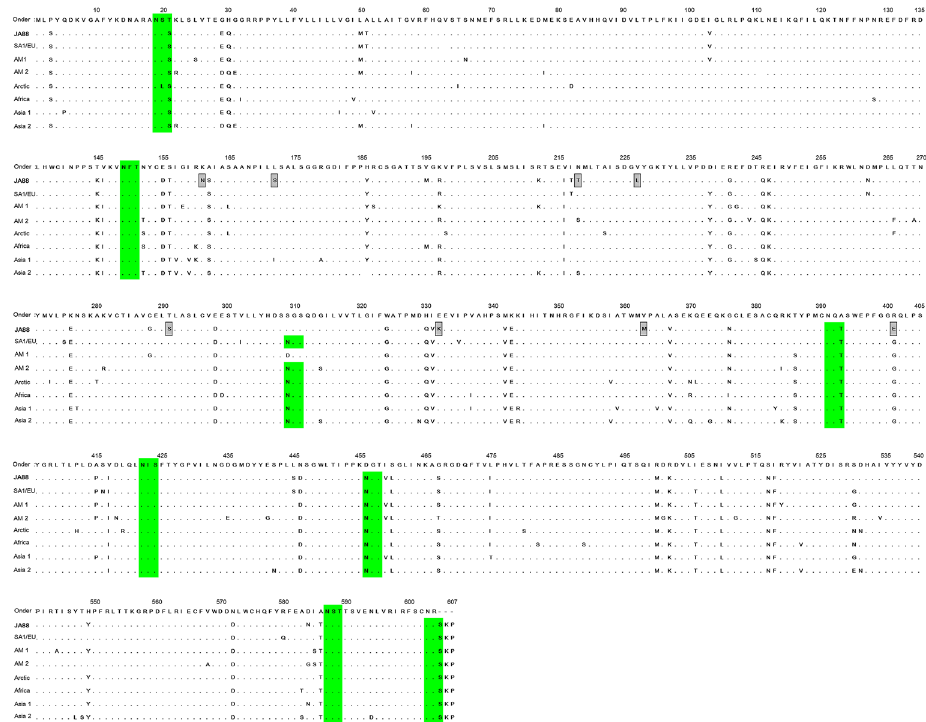
Figure 5. Amino acid sequence alignment of the CDV H protein from the Onderstepoort vaccine strain (AF305419); a wild-type strain from Brazil (JA88); and seven wild-type strains from Uruguay (SA1/EU: KM280689), the United State of America (AM1: EU716337; AM2: AY542312), Italy (Arctic: KF914669), South Africa (KY971528), China (AS1: JN896331), and Japan (AS2: AB490670). The gray box indicate amino acid residues unique to JA88 strain. The green region represents motifs associated with potential N-glycosylation sites (N-X-S/T). Dots (·) indicate